Question: In a single sentence, describe what this figure presents.
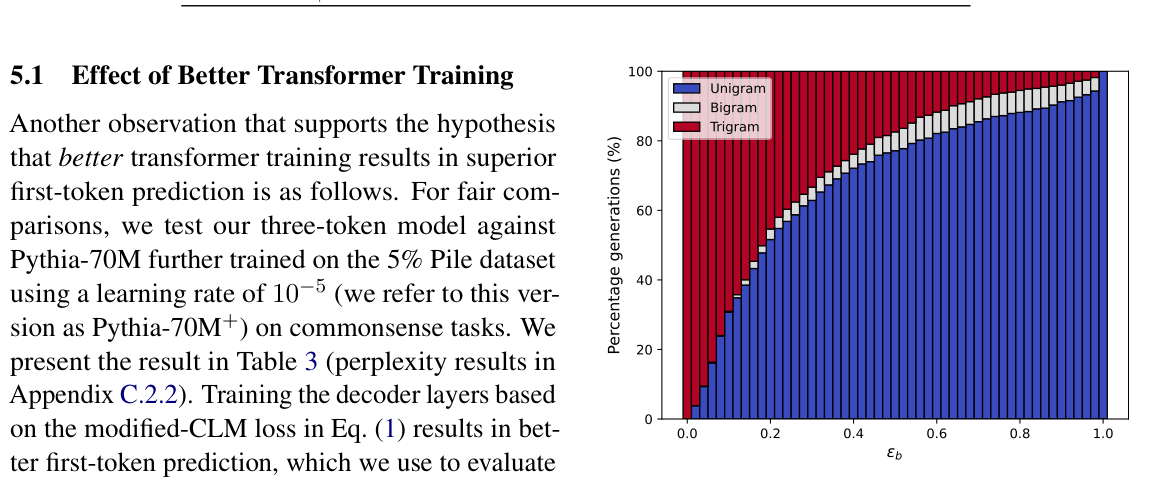
Answer: shows the percentage of one-token, two- token, and three-token generations as we sweep ϵb with DynaMo-70M-T3. When ϵb = 1.0, the model always generates one token at a time. When ϵb = 0.0, the model always generates three tokens at a time, regardless of its confidence in the gener- ations. Surprisingly, we note that the contribution of two-token generations is low; the model banks on three-token generations instead. We defer fur- ther exploration to balance multi-token generations